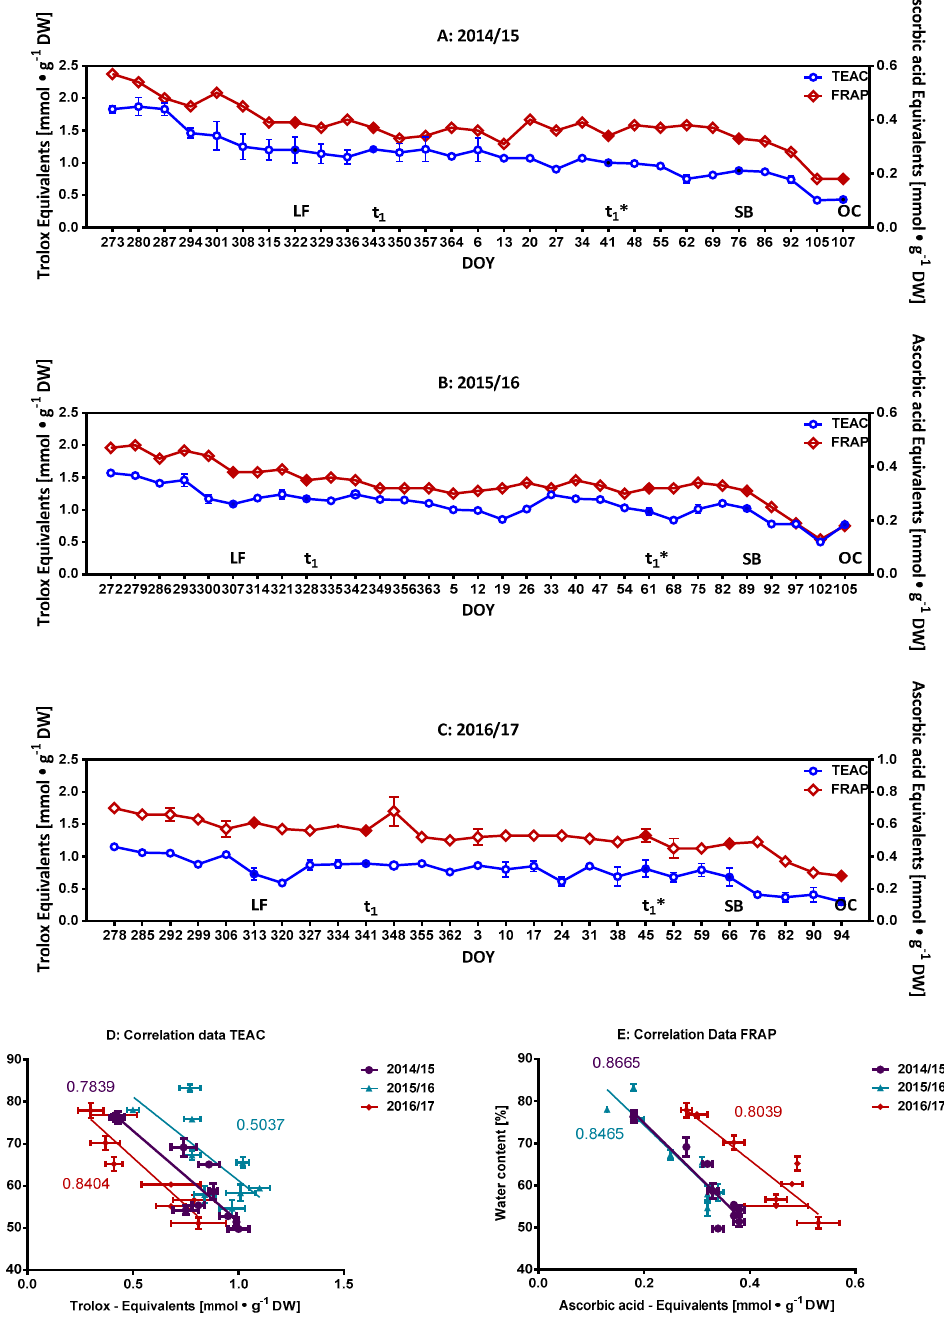
Figure 3. Weekly and developmentally orientated changes in anti-oxidative potential. Data is presented as Trolox (TEAC) or ascorbic acid (FRAP) equivalents. ( A ) Season 2014/15; ( B ) Season 2015/16 and ( C ) Season 2016/17. Filled symbols indicate key developmental milestones; ( D ) Correlation of water content v/s TEAC values; ( E ) Correlation of water content v/s FRAP values; both for the buds of the phenophase t 1 *–OC. Abbreviations: LF, leaf fall; t 1 = endodormancy release, t 1 * = beginning of ontogenetic development, SB = swollen bud, SG = side green, GT = green tip, TC = tight cluster, OC = open cluster, DOY, day of year; DW, dry weight.